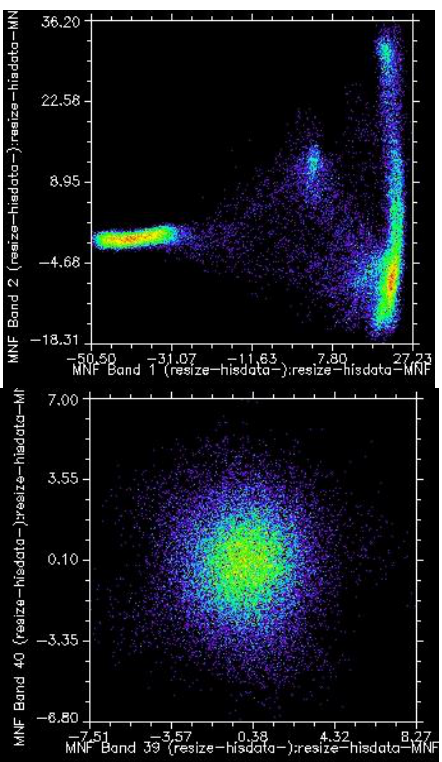
Fig.6. MNF plot shows the eigenvalue 5 corresponds to the 10 first MNF bands.